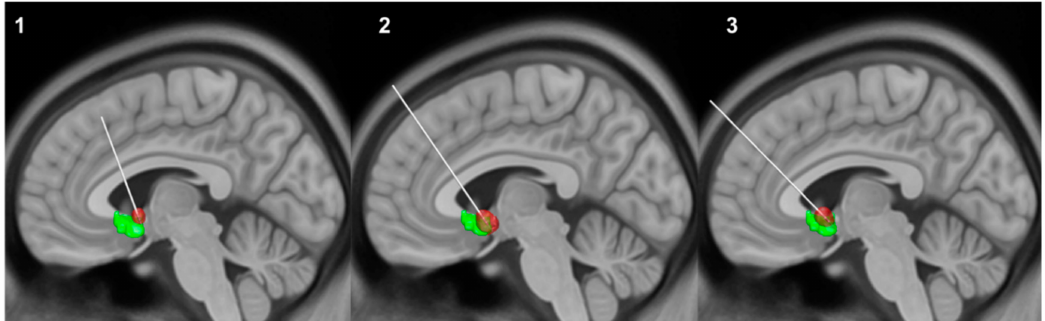
Figure 1. Overview of electrode localization of each individual subject (1–3) and corresponding volumes of activated tissue (VAT) (red) depending on stimulation settings at time of imaging acquisition. More distal contacts were implanted in the ventral striatum (green); more proximal contracts were located in the ventral capsule. Only left electrodes are shown for display purposes. For a closer view see Figure